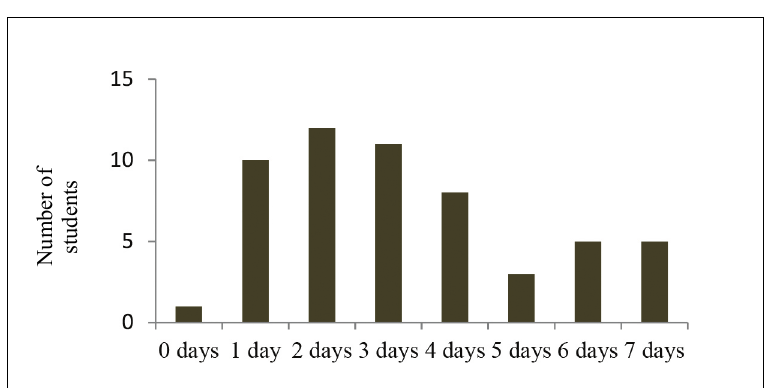
Figure 1. Frequency of practicing the first